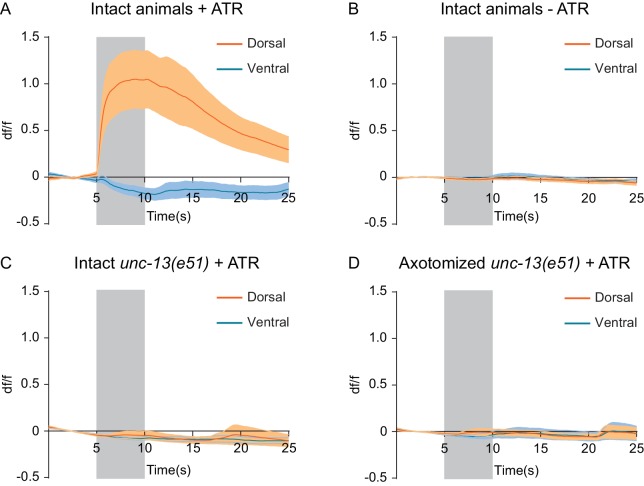
Optogenetically induced muscle calcium response requires all-trans retinal and depends on synaptic transmission.(A) Calcium responses in intact adult animals cultured with all-trans retinal (ATR) (n = 17). (B) No calcium responses in intact adult animals cultured without ATR (n = 24). (C) No calcium responses in intact unc-13(e51) animals with ATR (n = 25). (D) No calcium responses in unc-13(e51) animals 48 hr after axotomy with ATR (n = 24).